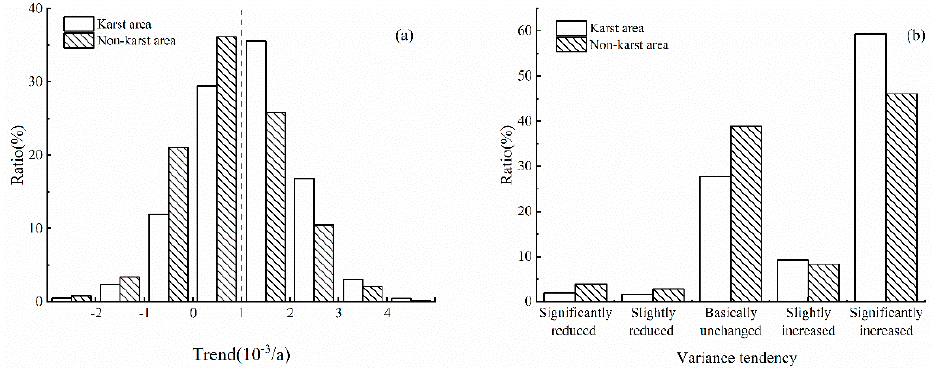
Figure 11. Comparisons of NDVI trend in different ranges ( a ) and variance tendency ( b ) between karst area and non-karst area in Southwest China from 1982 to 2015.